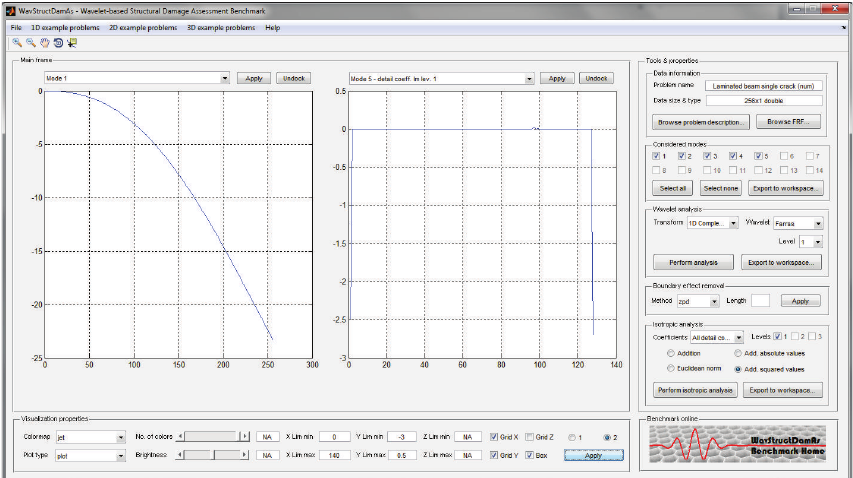
Figure 9: A benchmark window with results of laminated composite beam with a single crack example problem obtained using DTWT-based